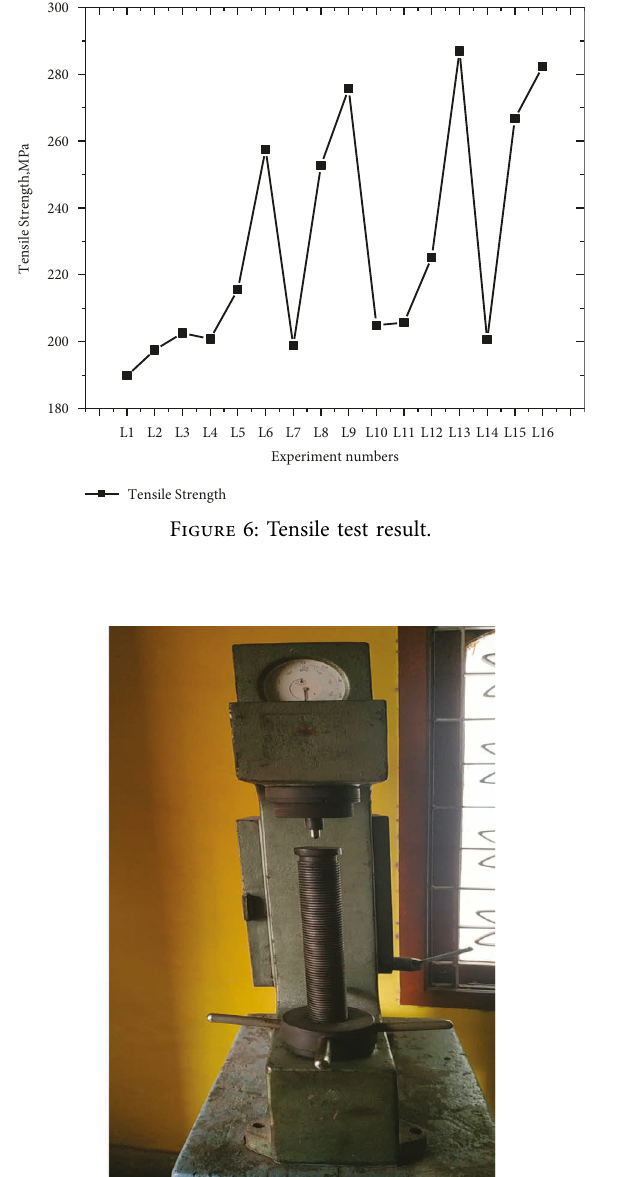
Figure 7: Hardness machine.